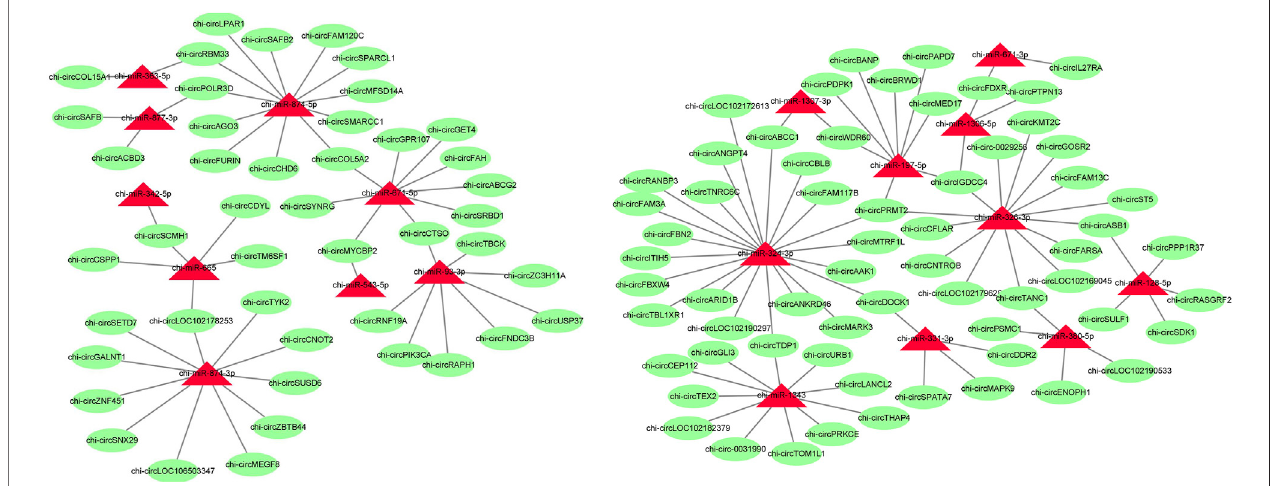
FIGURE 6 | Predicted target relationships of circRNAs and miRNAs. Red triangles represent miRNAs. Green circles represent circRNAs.